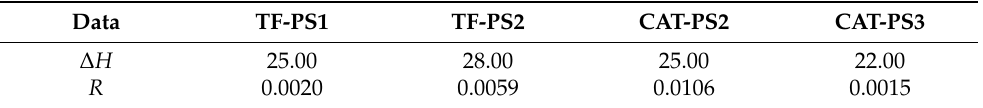
Table 5. Set-Point curve parameters for every PS.